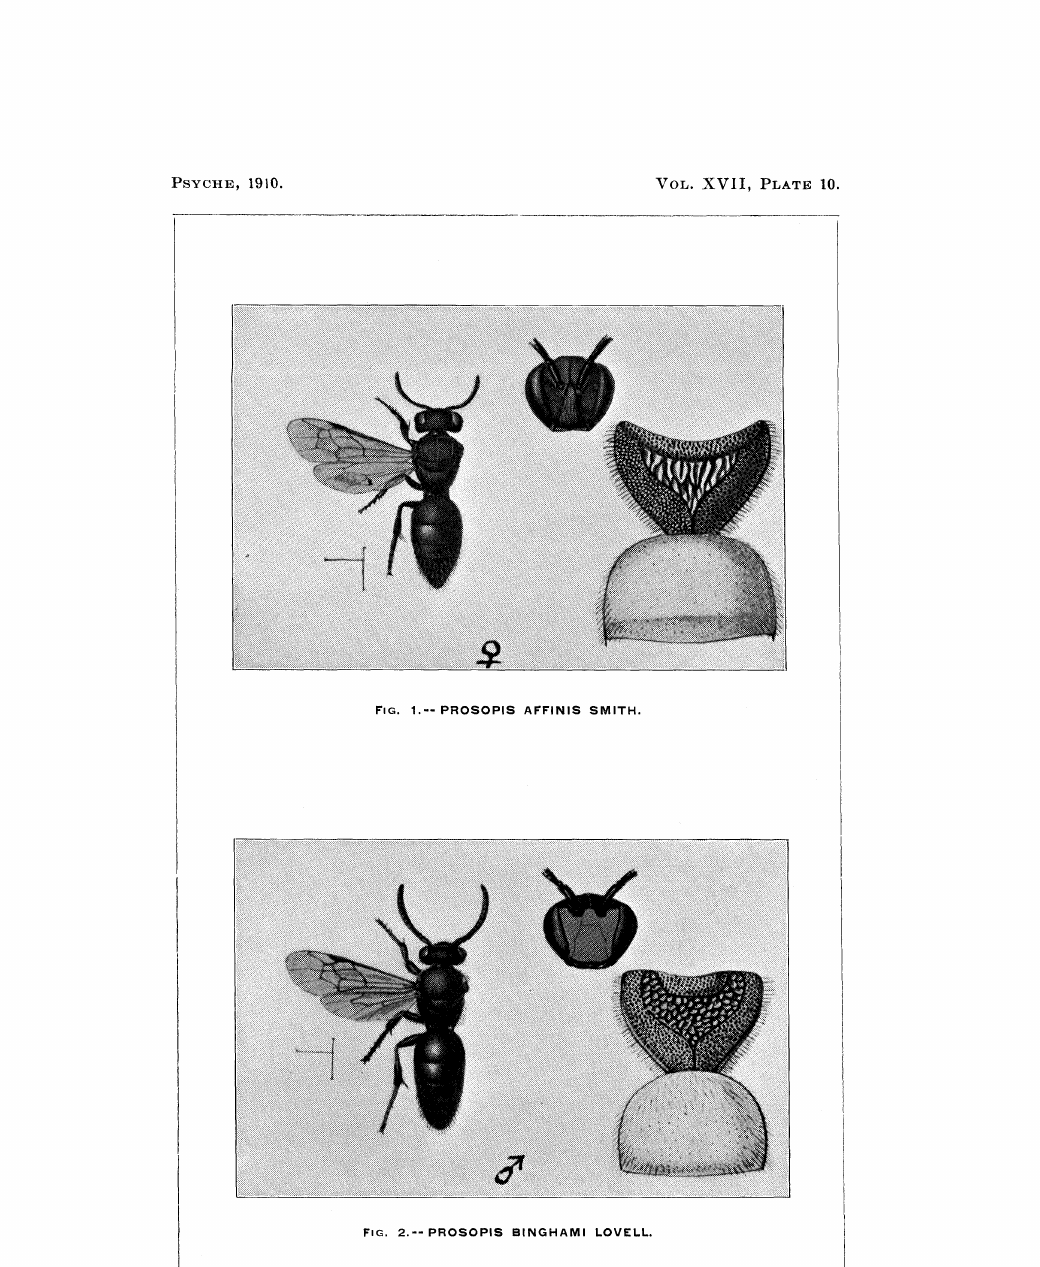
LOVELL-- PROSOPIDIDAE OF SOUTHERN